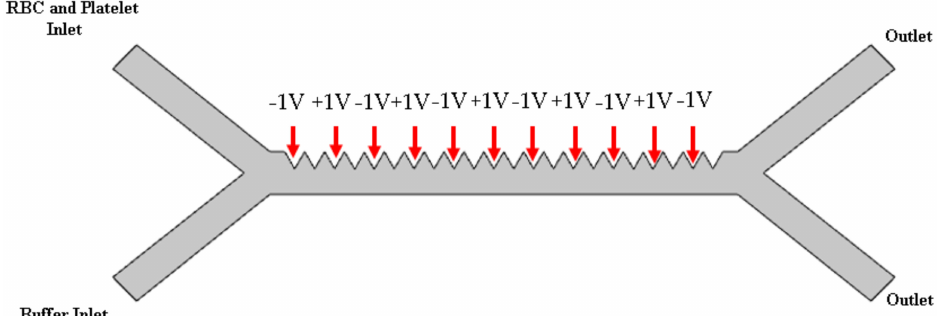
Figure 5. Proposed microfluidic design with saw-tooth electrode profile.